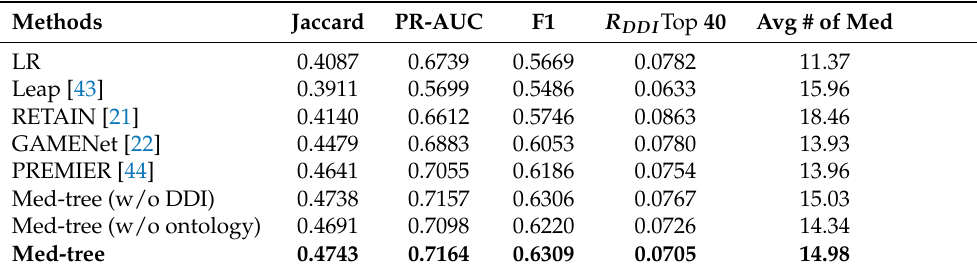
Table 4. Collaborative medication recommendation performance of different methods obtained on MIMIC-III datasets. The average number of medicines on the test set is 14.61.